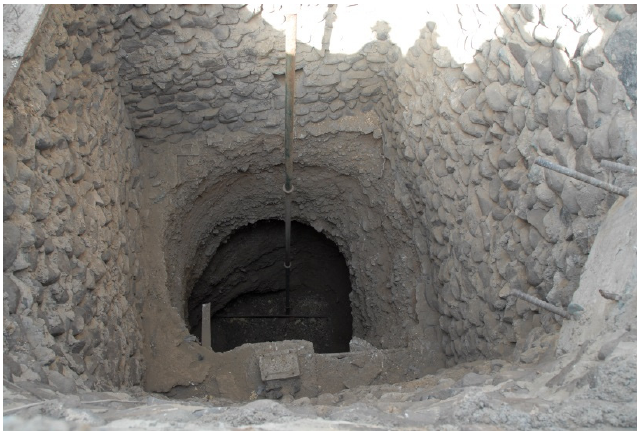
Figure 4. Dry well in Wadi Qidayd showing fining upward bedding in the lower part of the